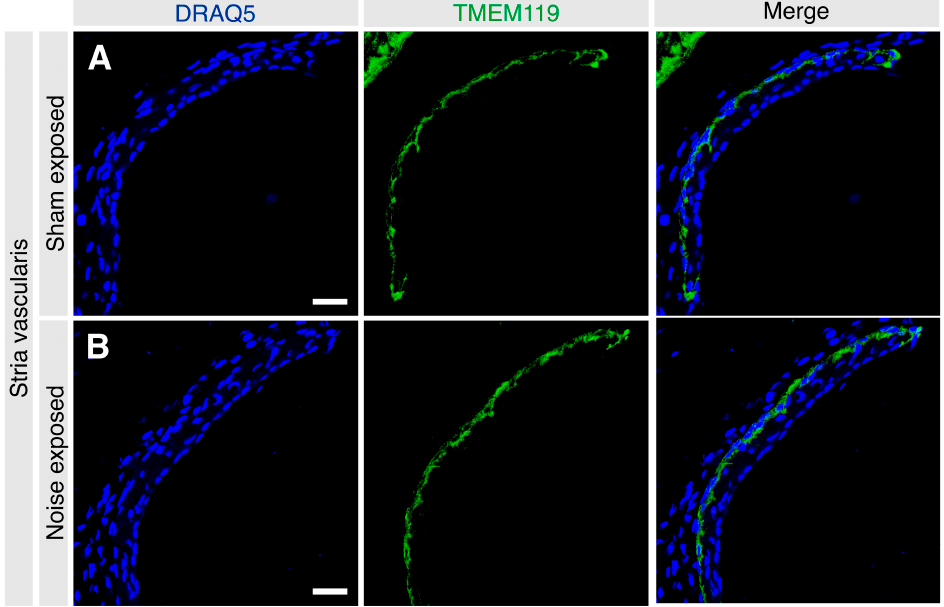
Figure 5. High magni fi cation confocal microscopic images of the stria vascularis in sham-exposed ( A ) and noise-exposed ( B ) adult cochleae labeled for TMEM119 (green) and counterstained with DRAQ5 (blue). TMEM119 protein was detected in both groups’ basal cells of the stria vascularis seemingly without any detectable di ff erence. Scale bar: 20 µm.